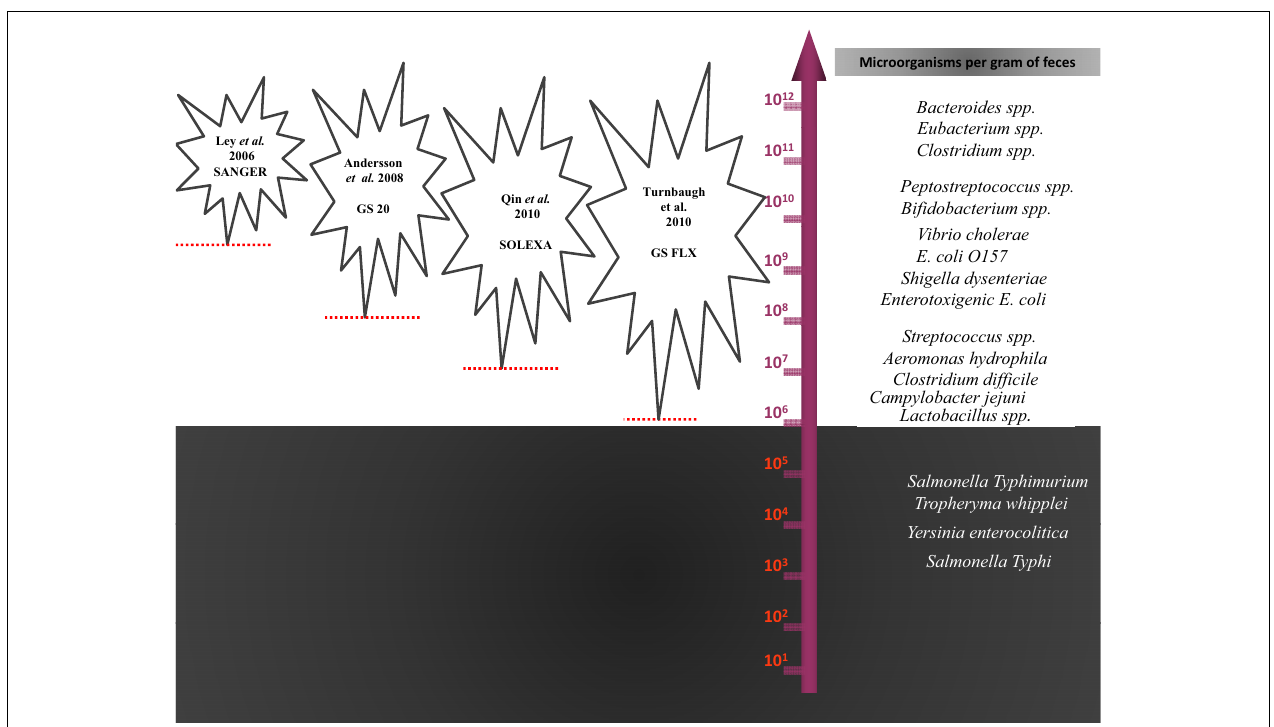
FIGURE 3 |The statistical detection thresholds of metagenomic methods. The statistical detection thresholds of metagenomic methods are correlated with the number of bacteria in the ecosystem studied by the number of sequences generated.